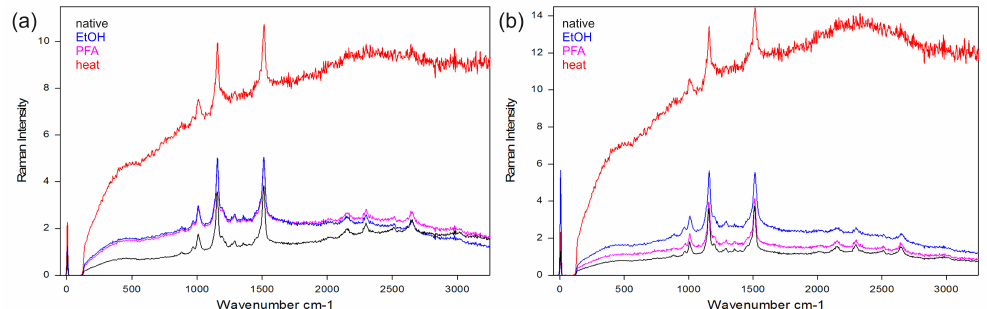
Figure 1. Resonant Raman spectra at excitation with 532 nm of the bacterial strains rhodopseudomonas palustris ( a ) and rhodospirillum rubrum ( b ) and the effect of treatment with different fixatives compared to the Raman spectrum of the native bacteria. The main Raman-active chromophore for both strains is the carotenoid spirilloxanthin with dominant lines at 1509 cm − 1 , 1151 cm − 1 , and 1004 cm − 1 (reproduced with permission from